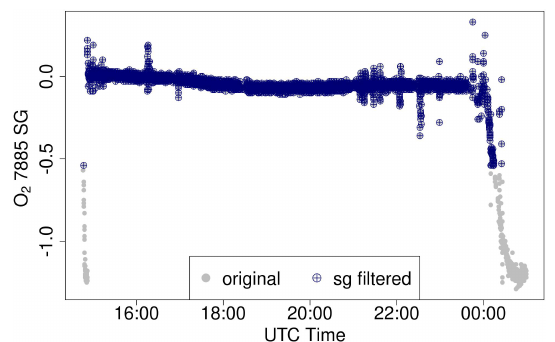
Figure A1. EM27/SUN solar gas shift (SG) values before (grey) and after the additional filtering (blue). Units of SG are ppm of the spacing of the spectral